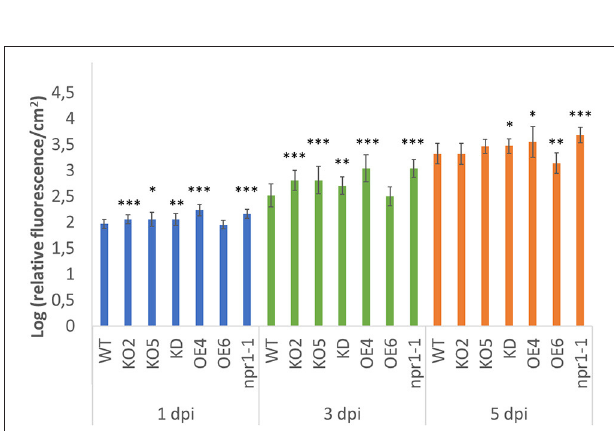
FIGURE 6 | Fluorescence measured in 2-week-old Arabidopsis thaliana plants infected with GFP-labeled Pst DC3000 strain at 1-, 3-, and 5-days post-infection. Fluorescence was calculated using the log of the ratio cGFP/cm 2 in order to represent the fluorescence in the plant. Comparison between wild-type plants and transgenic lines was performed using independent samples T -test for normally distributed data and Mann-Whitney test for non-normally distributed. Asterisks indicate statistically significant differences between WT and transgenic lines (* p ≤ 0.05; ** p ≤ 0.01; *** p ≤ 0.001). cGFP: corrected Green Fluorescent Protein